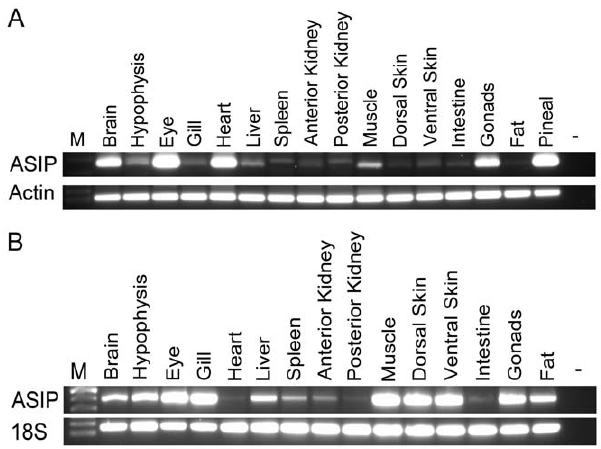
Figure 4. RT-PCR analysis of the tissue specific expression pattern of asip1. (A) Turbot and (B) sole.